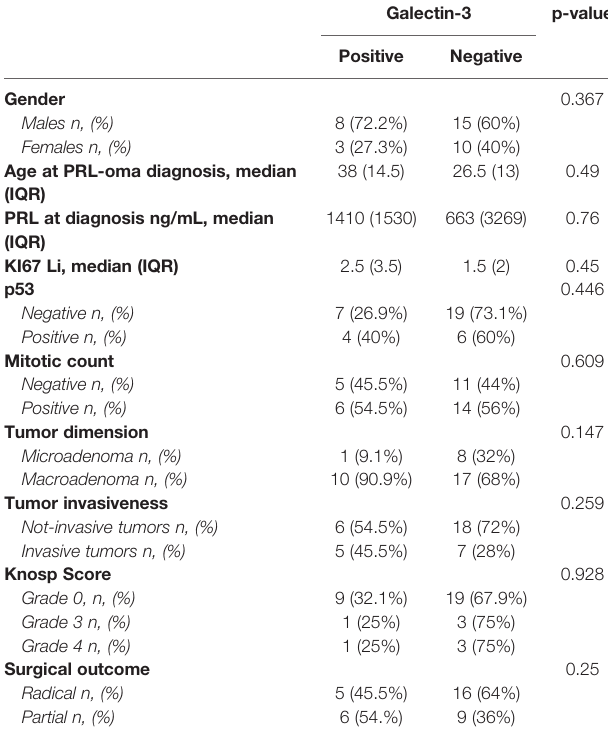
TABLE 1 | Galectin-3 expression in study population. Univariate